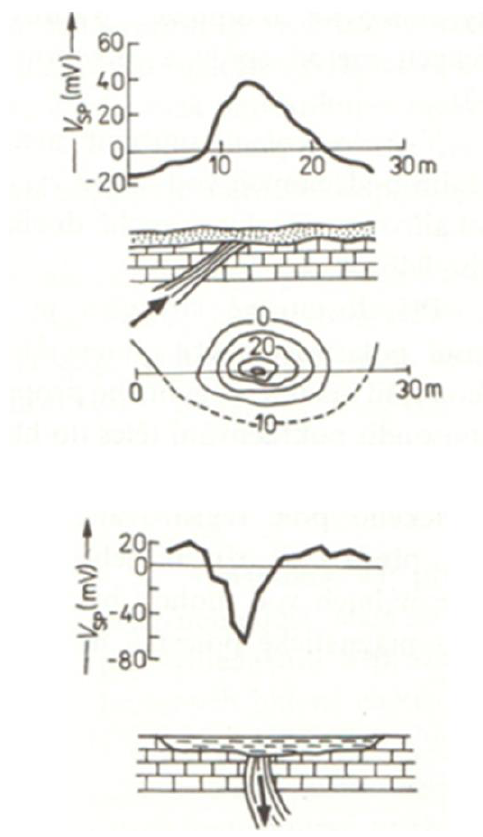
Figure 8. The generation of filtration potentials in the crack (by Karous 1989)